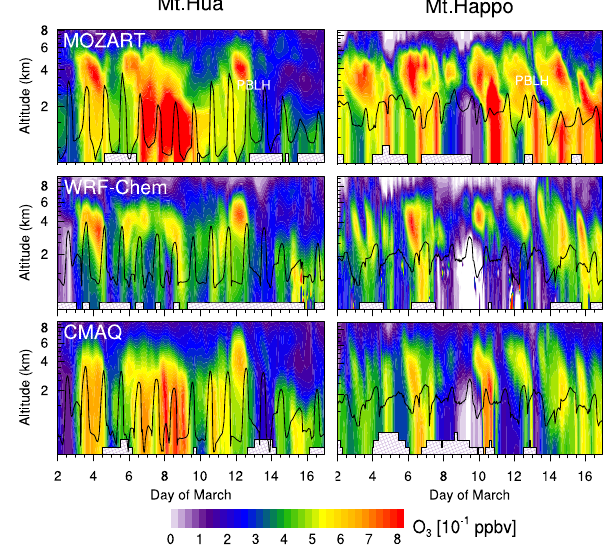
Figure 9. Time and vertical evolution of O 3 responses over China(Mt.Hua) and Japan (Mt.Happo) in association with 20% perturbations in European emissions. The black line represents boundary Fig. 9. Time and vertical evolution of O 3 response over China and layer depths. The hatched areas indicate local surface pressure below the bottom pressure level Japan in association with a 20% perturbation in European emis- used for vertical interpolation. sions. The black line represents boundary layer